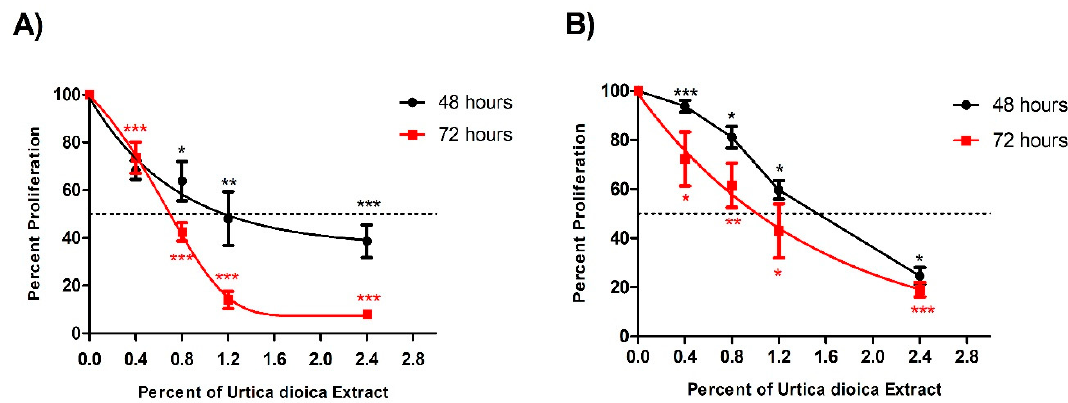
Figure 1. Effect of varying UD extract concentrations on the viability of U937 and KG-1 cells after 48 and 72 h. ( A ) U937 cells showed a significant decrease in proliferation, with an IC 50 at 1.1% of UD extract after 48 h and at 0.7% after 72 h. ( B ) KG-1 cells showed a significant decrease in proliferation, with an IC 50 at 1.5% of UD extract after 48 h and at 1.0% after 72 h. The figure represents the results from three independent experiments and the error bars represent SEM. *, **, and *** indicate p < 0.05, p < 0.001, and p < 0.0001, respectively, compared to the control group.